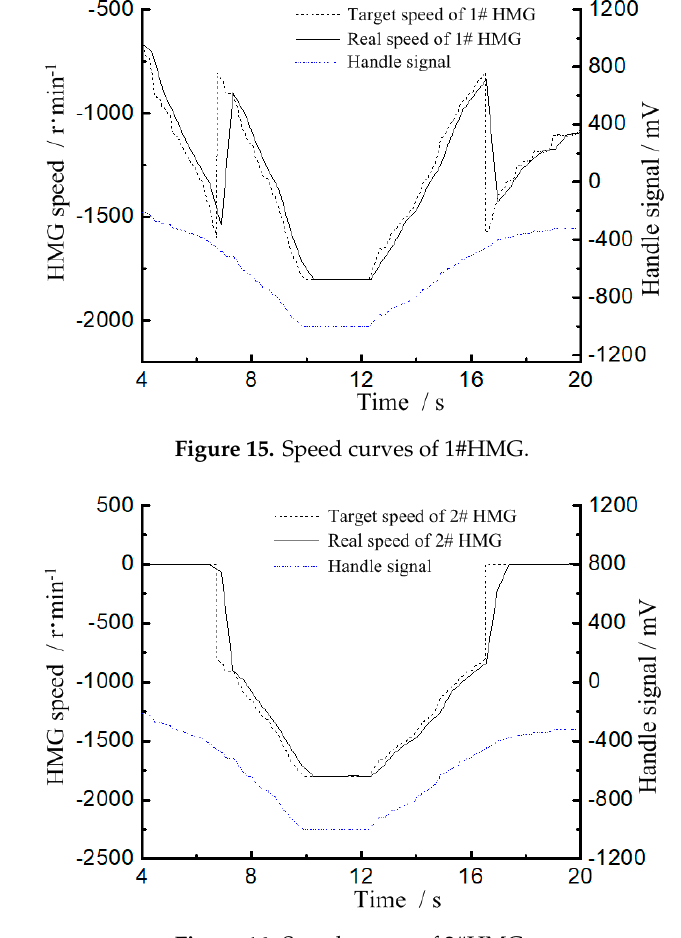
Figure 16. Speed curves of 2#HMG.